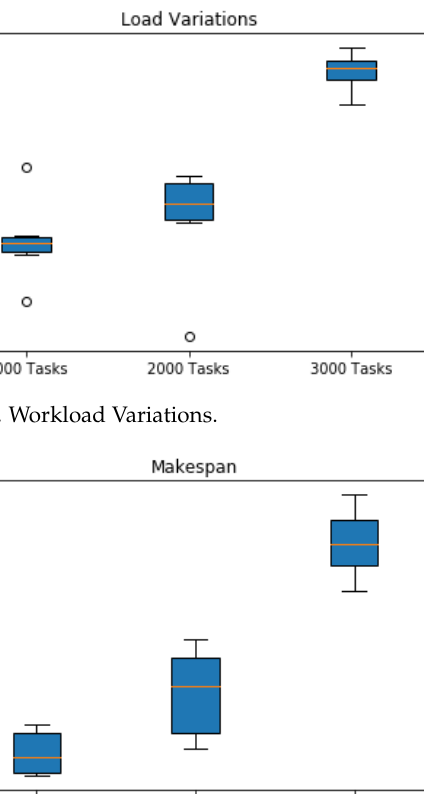
Figure 13. Makespan with 3000 tasks.